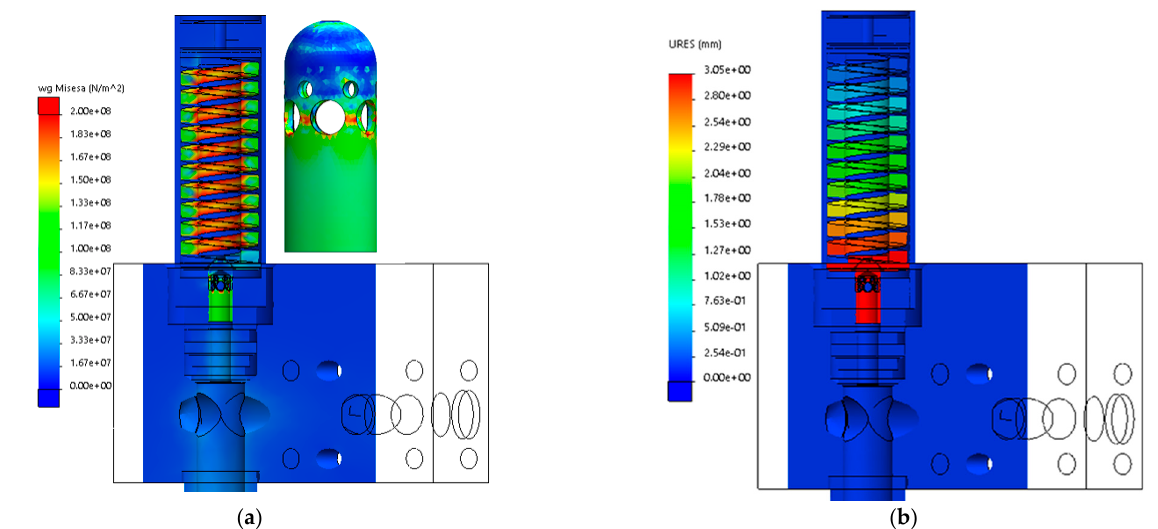
Figure 24. The variation map of von Misses stress ( σ ) ( a ) and displacement ( d) ( b ) for a 0.01 m 3 ·s -1 volume flow rate (600 L·min -1 ).